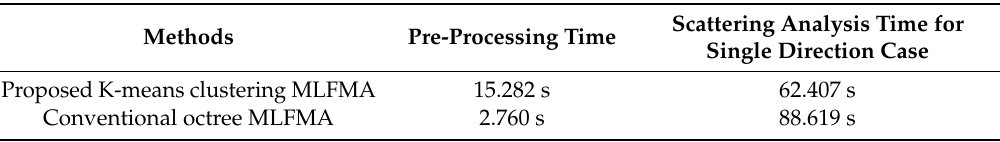
Table 2. Comparisons of the computation time of the conventional and proposed MLFMA for the canonical sphere CAD model with 100,000 basis functions (1-degree